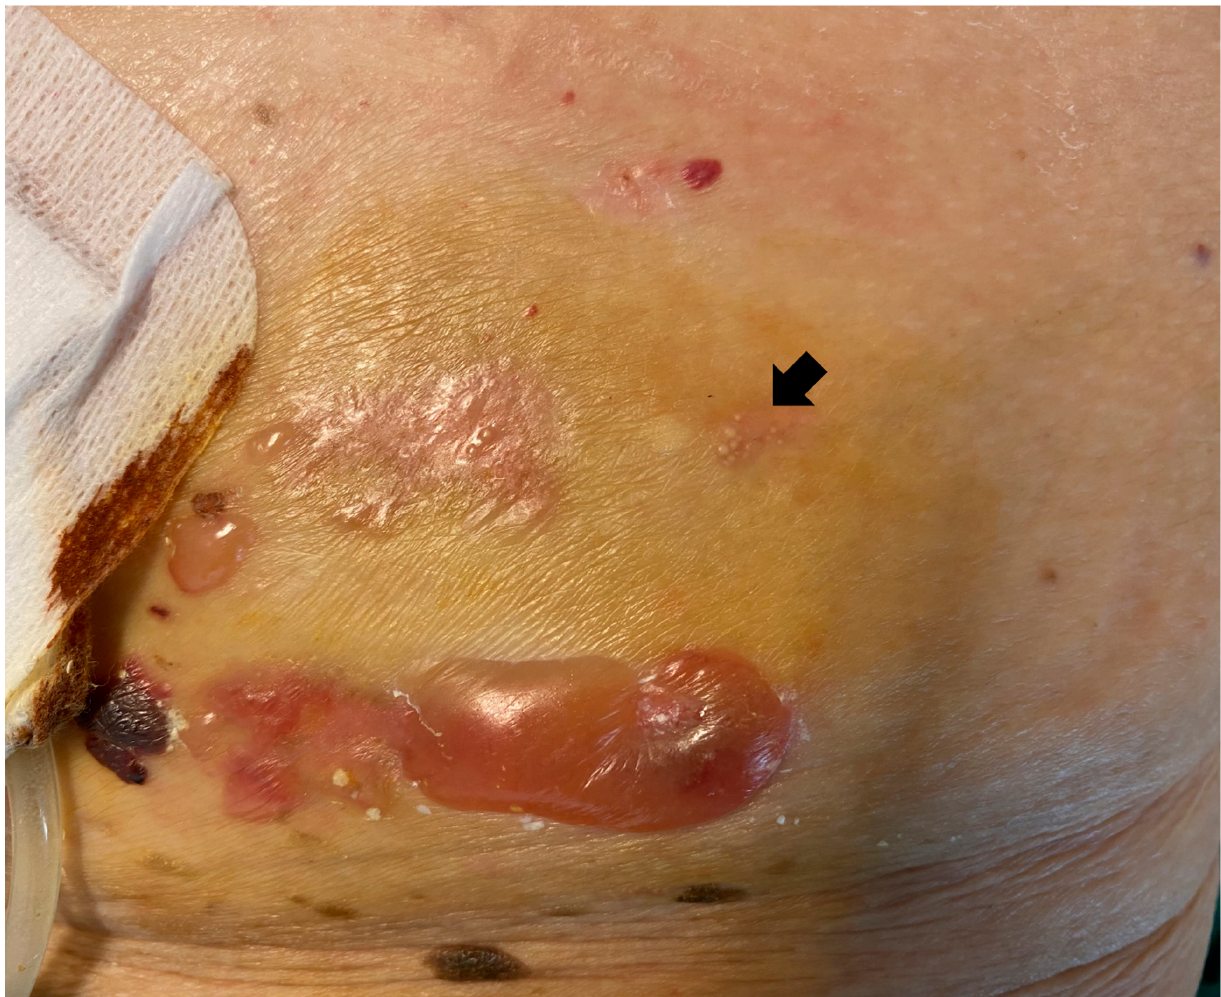
Figure 1. Tense vesicles, blisters and crusts surrounding around the peritoneal dialysis catheter exit site. Milia can be observed (arrow).